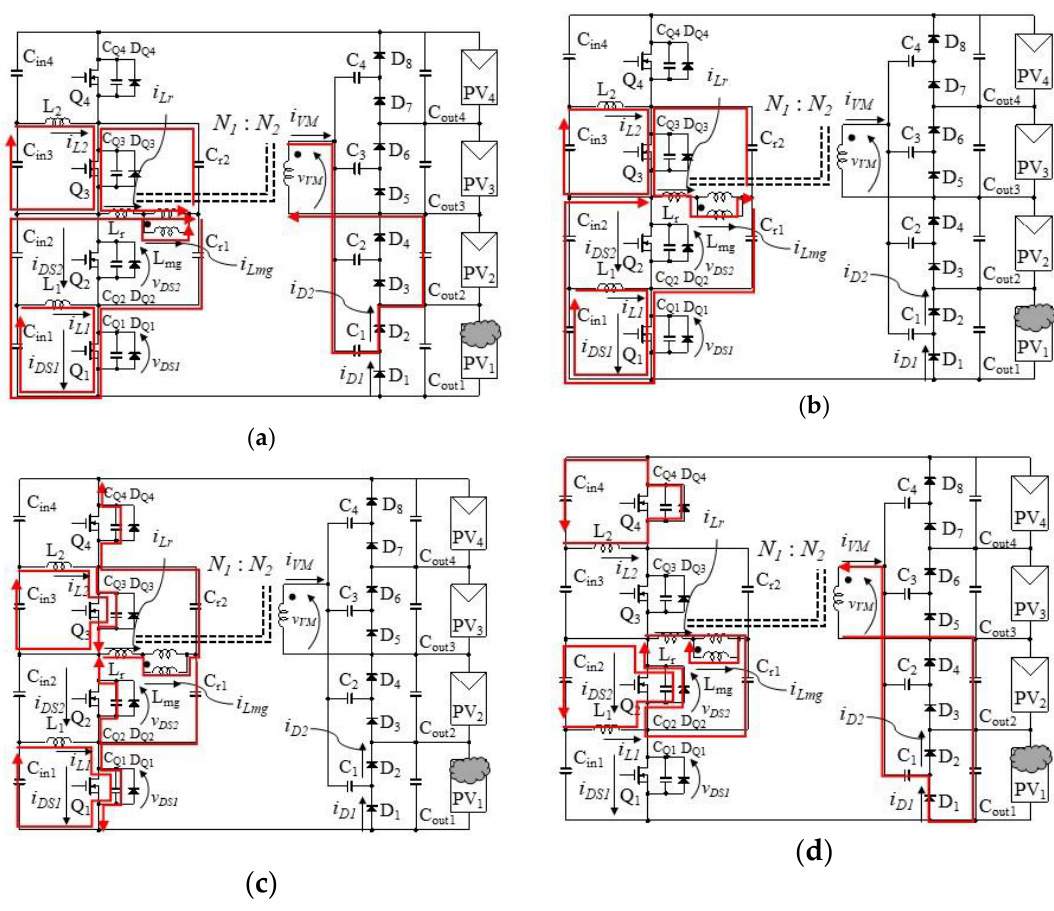
Figure 9. Operation modes: ( a ) Mode 1; ( b ) Mode 2; ( c ) Mode 3; ( d ) Mode 4.